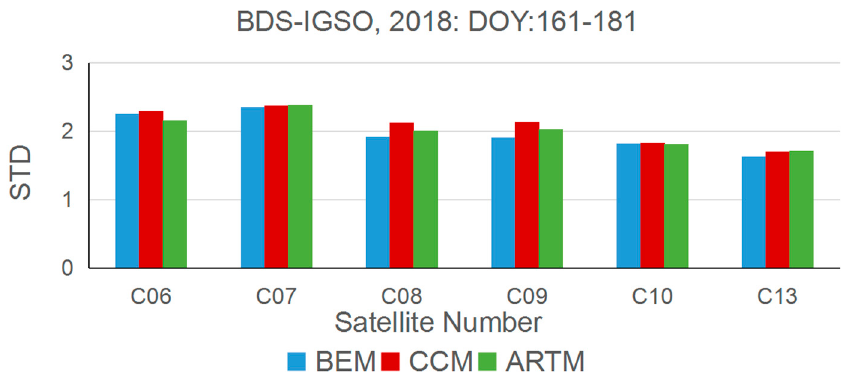
Figure 7. The STD of the satellite repeat shift time for the three methods for each satellite during the period DOY:161–181, 2018.